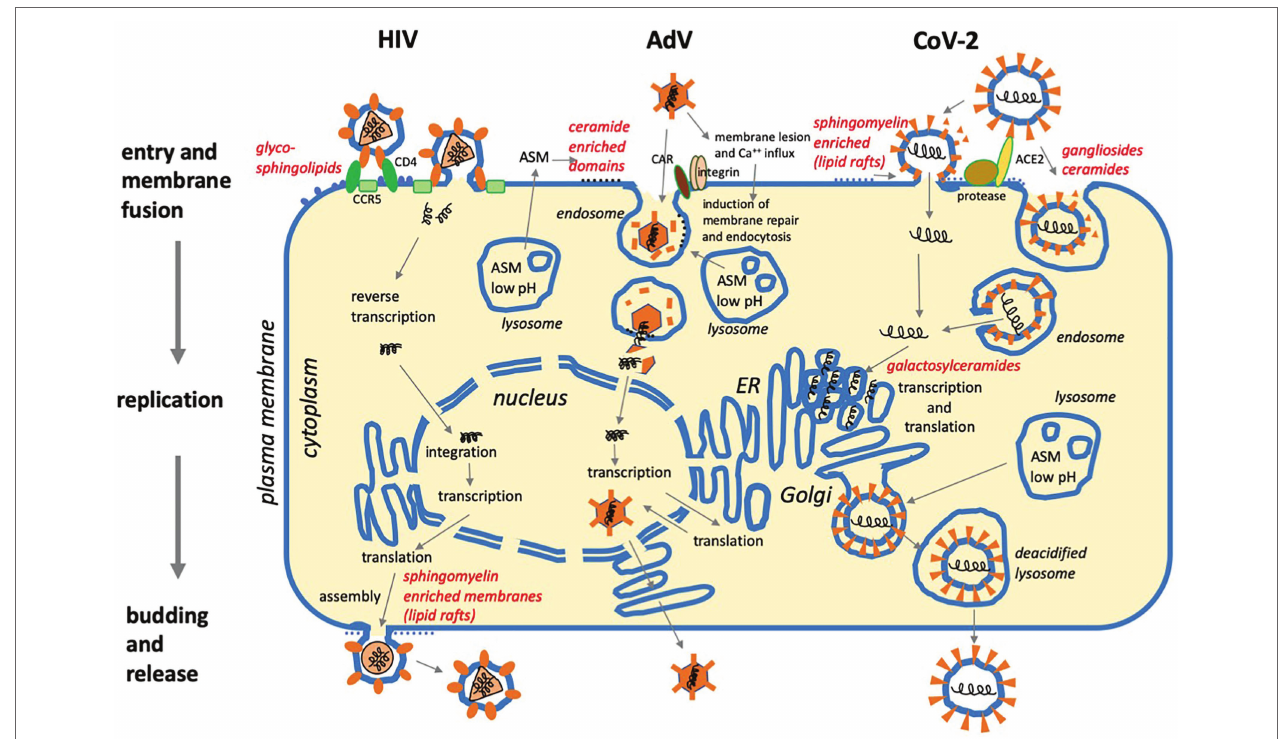
FIGURE 2 | Three examples of viral replication cycles and involvement of sphingolipids: (1) Human immunodeficiency virus (HIV) binds to glycoshingolipids, CD4, and co-receptors CCR5 or CXCR4 prior to membrane fusion at the plasma membrane. After reverse transcription of the positive-strand RNA genome and integration in the cellular DNA, the virus exploits the cellular machinery for transcription and translation. Assembly and budding take place at the plasma membrane with the involvement of sphingomyelin-enriched membrane domains (lipid rafts). (2) Adenovirus (AdV) binds to CAR and integrins, then causes membrane lesions which induce Ca ++ influx and membrane repair. This occurs with the help of lysosomes requiring ASM activity, which supports viral uptake by endocytosis. After the disintegration of the viral capsid, the viral DNA is transported to the nucleus, and after transcription and translation, viral particles are assembled in the nucleus and released. (3) SARS Coronavirus-2 (CoV-2) requires protease activity and binds to ACE2, which is supported by sialic acid in ganglioside-enriched membrane domains prior to cell entry via fusion at the plasma membrane or endocytosis and subsequent membrane fusion. Transcription and translation take place on the cytoplasmic face of the ER. Galactosylceramide supports viral replication. After assembly, virus particles traffic to lysosomes for egress via lysosomal exocytosis (For references, see main